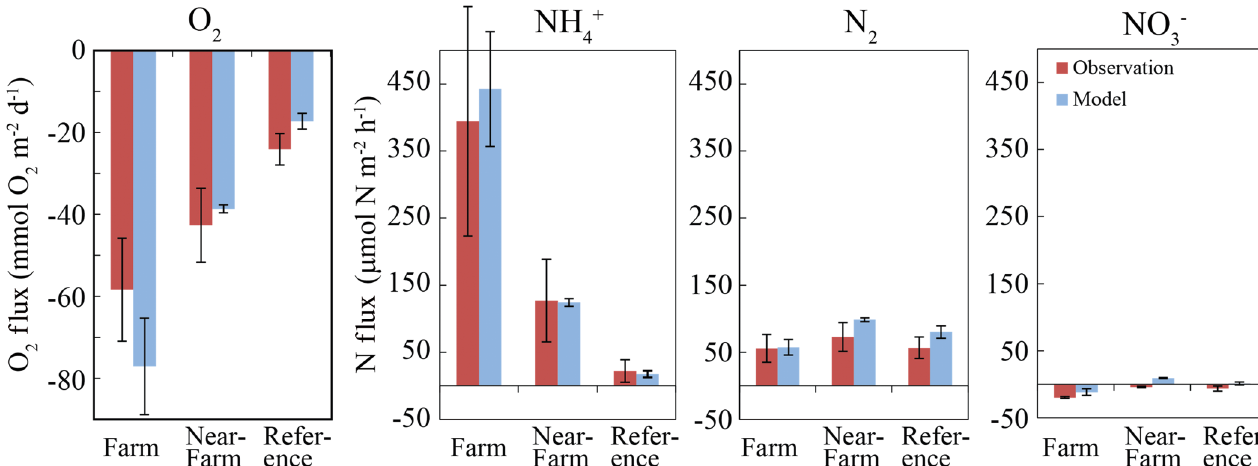
Fig. 5. Comparison of SFM O 2 , NH 4+ , N 2 , and NO 3− fluxes with observed fluxes at the reference, near-farm, and farm sites. For observations, data are the means (±SE) over the 4 sampling dates between April−September. For model simulations, data are means (±SE) over each